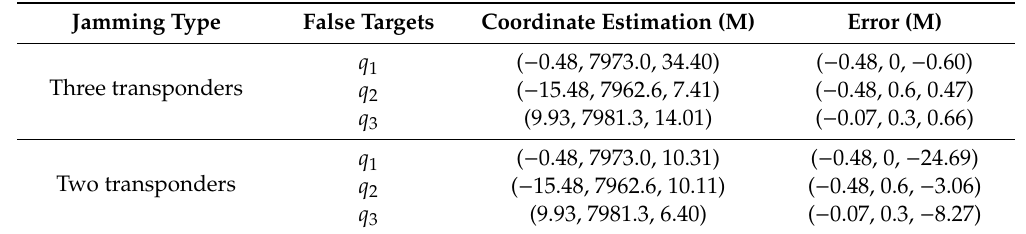
Table 5. Coordinate estimation and errors of three false point targets from the 3D deceptive